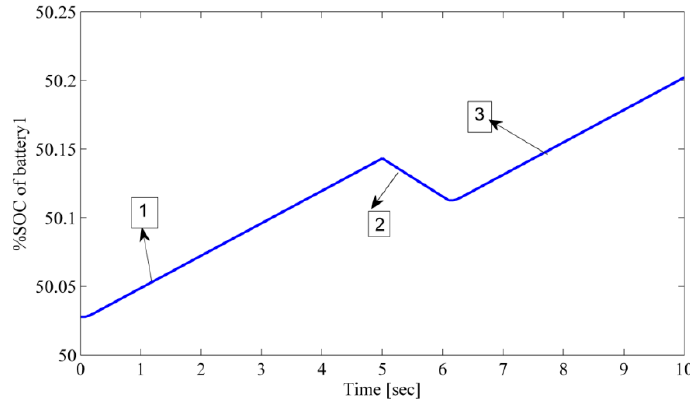
Figure 10. Percentage state of charge (SOC) of Battery 1 for different control modes (Point 1: Grid connected mode, Point 2: Islanded mode, Point 3: Reconnection mode).